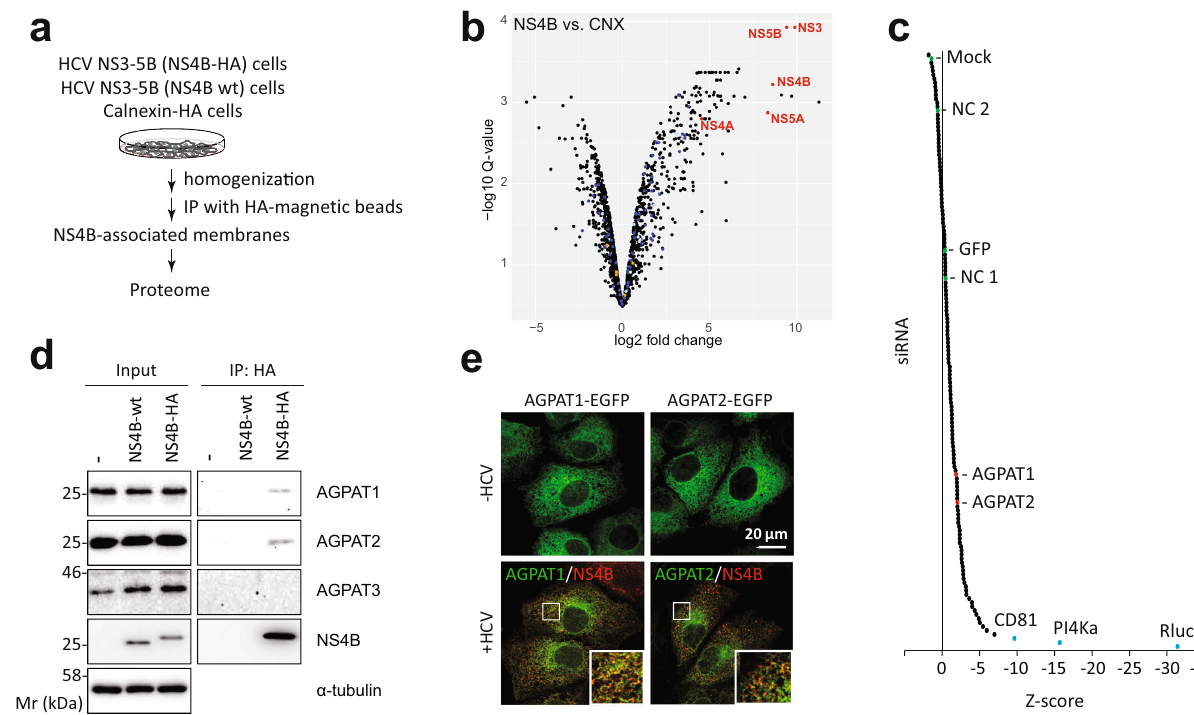
Fig. 1 Proteome analysis of HCV-induced DMVs identi fi es AGPATs as host dependency factors critically contributing to viral replication. a Experimental approach used to purify DMVs from HCV-replicating cells. b Volcano plot of differentially enriched interactors of NS4B and calnexin (CNX). Q-values were calculated using the limma software package and corrected for multiple hypothesis testing. Viral proteins are highlighted with red letters. A magni fi ed view with protein hits labeled is given in Supplementary Fig. 1B. c A total of 139 genes were selected from the DMV proteome and validated by siRNA screening (3 siRNAs per gene). CD81, PI4KA and Rluc were used as positive controls; NC (negative control)1, NC2, GFP and mock infection served as negative controls. A summary of the screening is given in Supplementary Data 2. d Endogenous AGPAT1 and 2, but not AGPAT3 are contained in